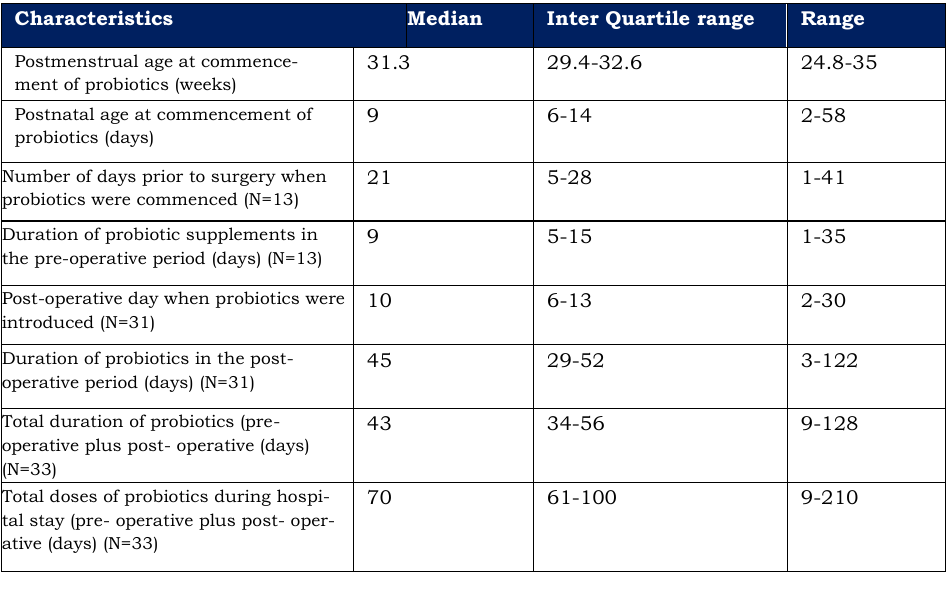
Table 2: Details of probiotic